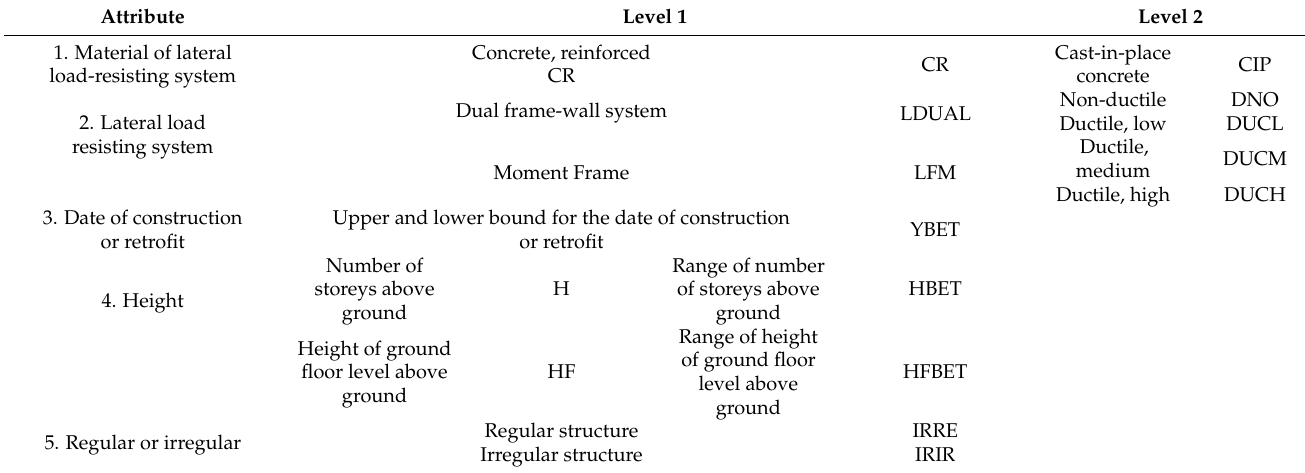
Table 2. Attributes of GEM Building Taxonomy used to describe Lisbon RC Buildings.